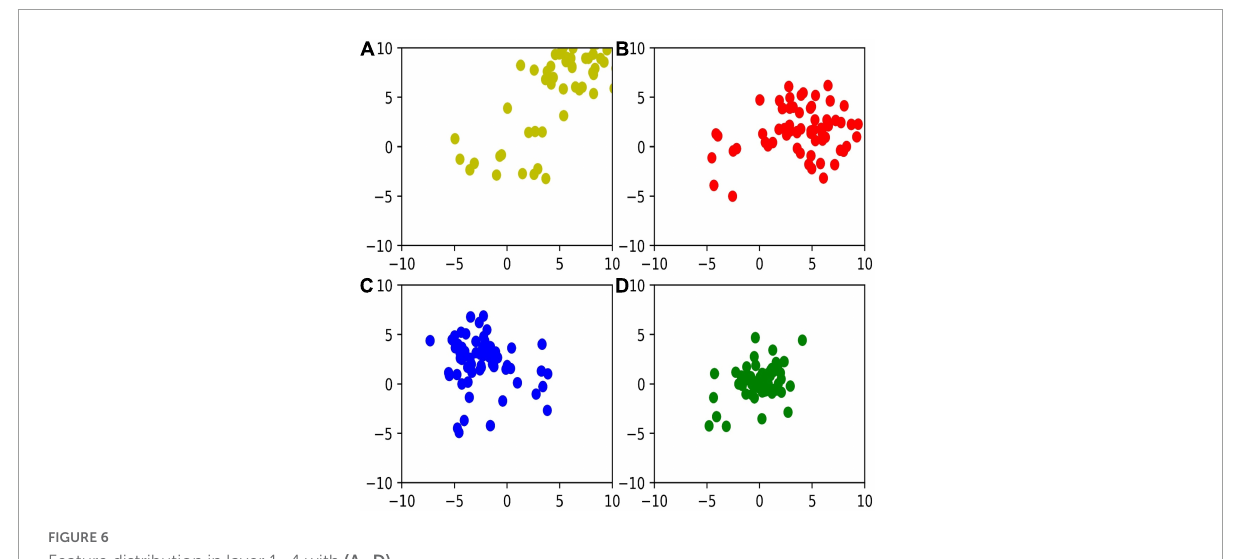
FIGURE5 12 basic movements signal of fingers in Exercise A.